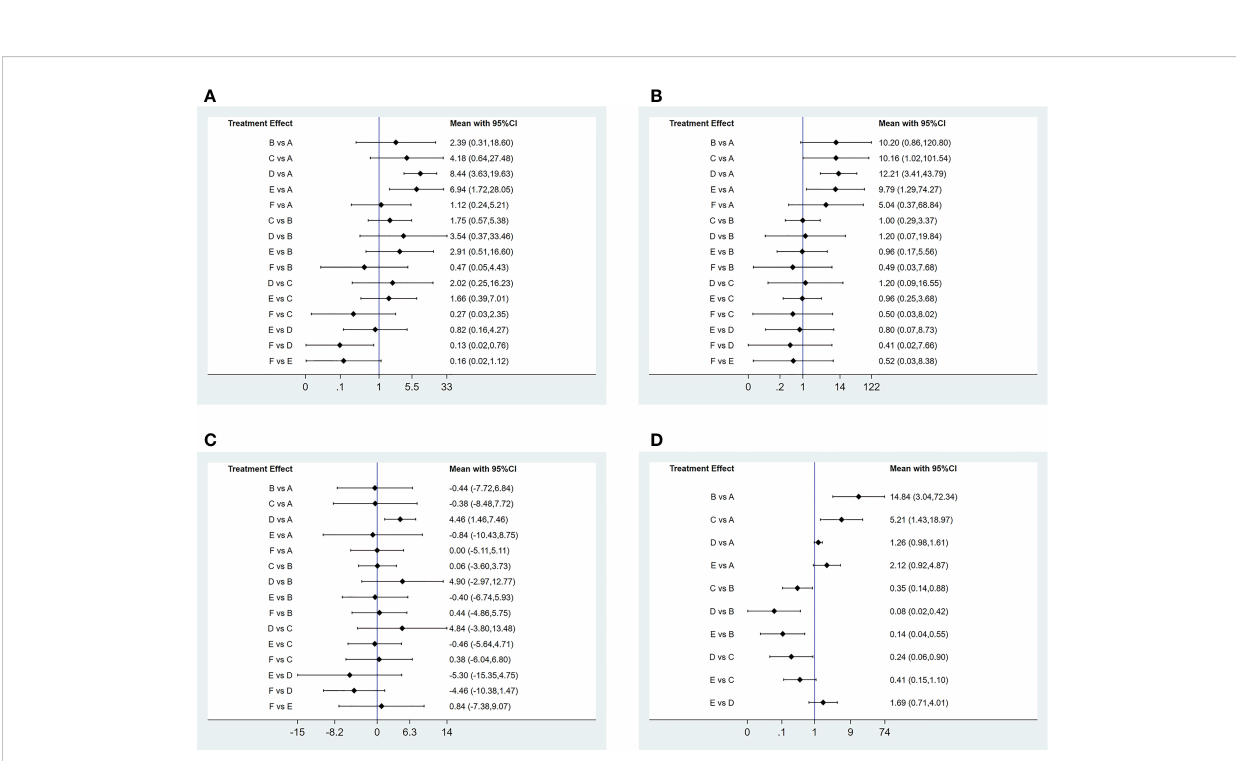
FIGURE 5 Pairwise comparison forest graph of outcome indicators. (A) good response rate; (B) complete response rate; (C) percent change from baseline in SALT score; (D) TEAE (treatment emergent adverse events) rate. A: placebo treatment B: conventional steroid therapy C: any dose of oral tofocitinib treatment D: any dose of oral baricitinib treatment E: any dose of oral ruxolitinib treatment : nonoral JAK inihibitor